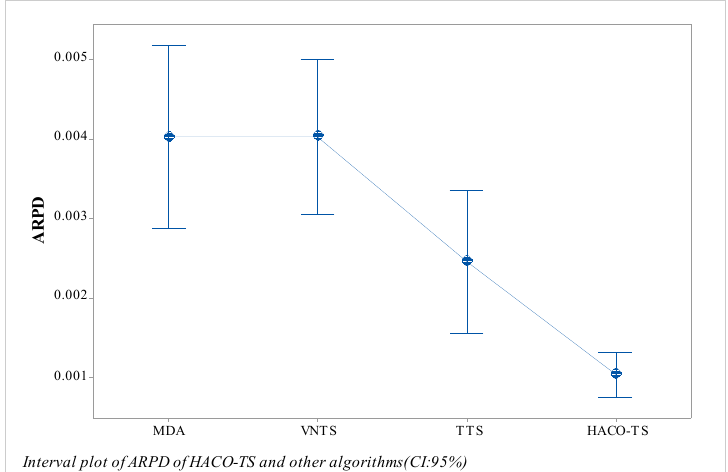
Fig. 8. Interval plot of ARPD of HACO-TS and other